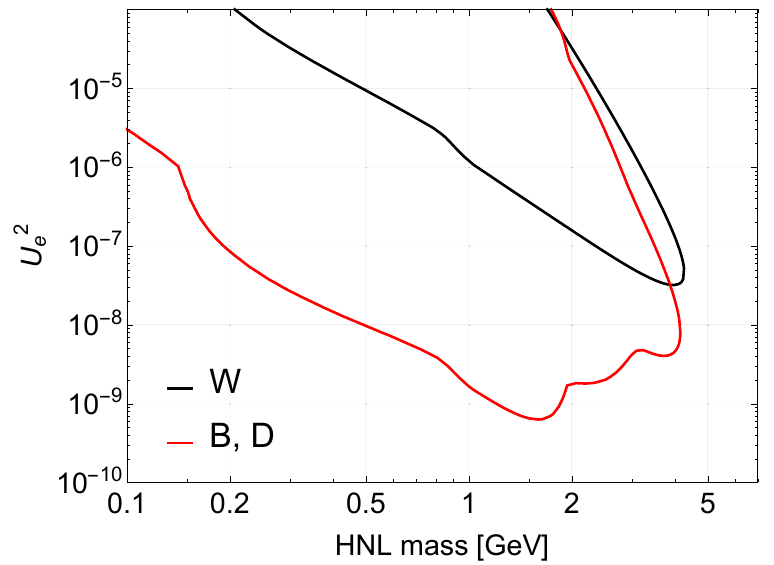
Figure 9 . Comparison of the sensitivity of the MATHUSLA experiment to the HNLs that are produced in decays of D and B mesons (including B